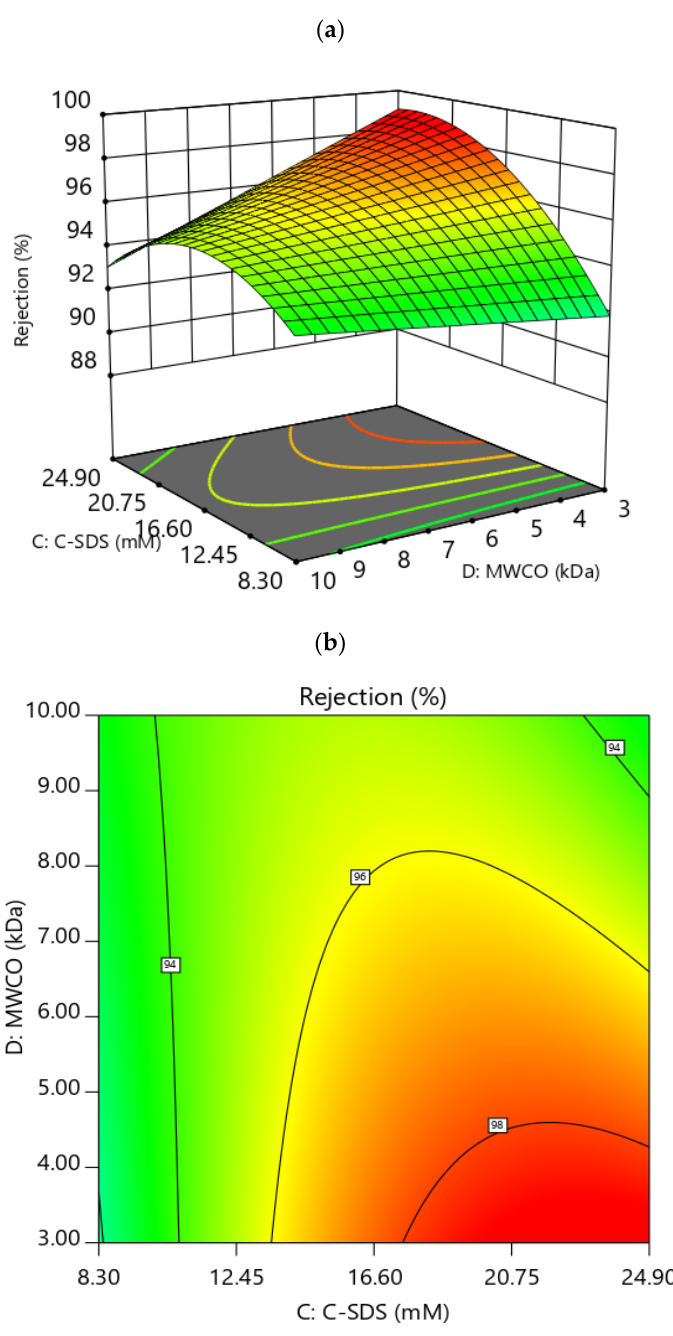
Figure 4. Response surface ( a ) and contour ( b ) showing the effect of SDS concentration and MWCO on rejection rate. Pressure = 40 psi, C Ni = 1.25 mM.